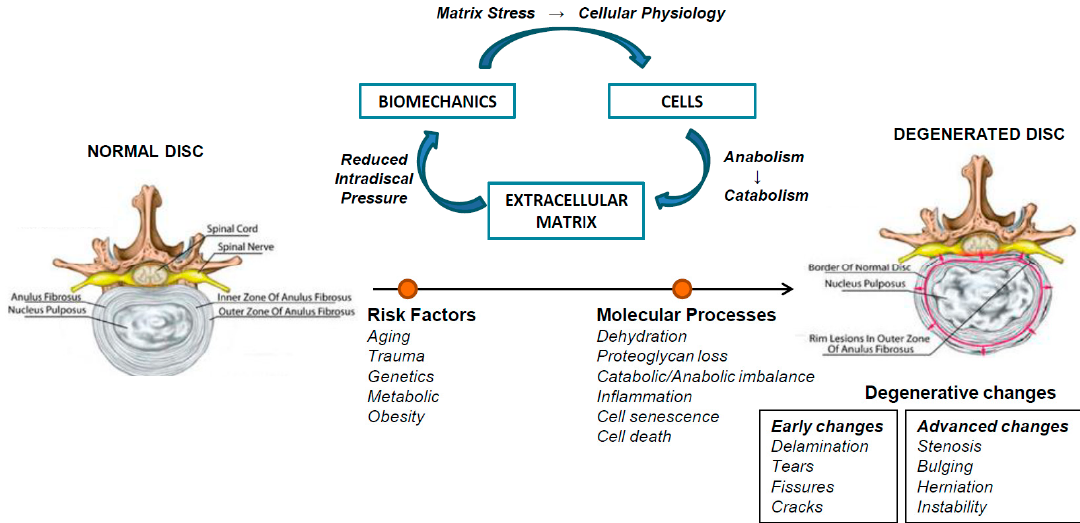
Figure 1. Pathophysiology of intervertebral disc disease. Homeostasis of the intervertebral disc depends on the interaction of biomechanical stress, cells and extracellular matrix. Several risk factors dysregulate this balance by triggering increased matrix degradation, angiogenesis / neovascularization, and enhanced expression of catabolic cytokines and nerve ingrowth. Decreased production of proteoglycans lead to a reduction in hydrostatic pressure and increase in shear forces leading to progressive degeneration.